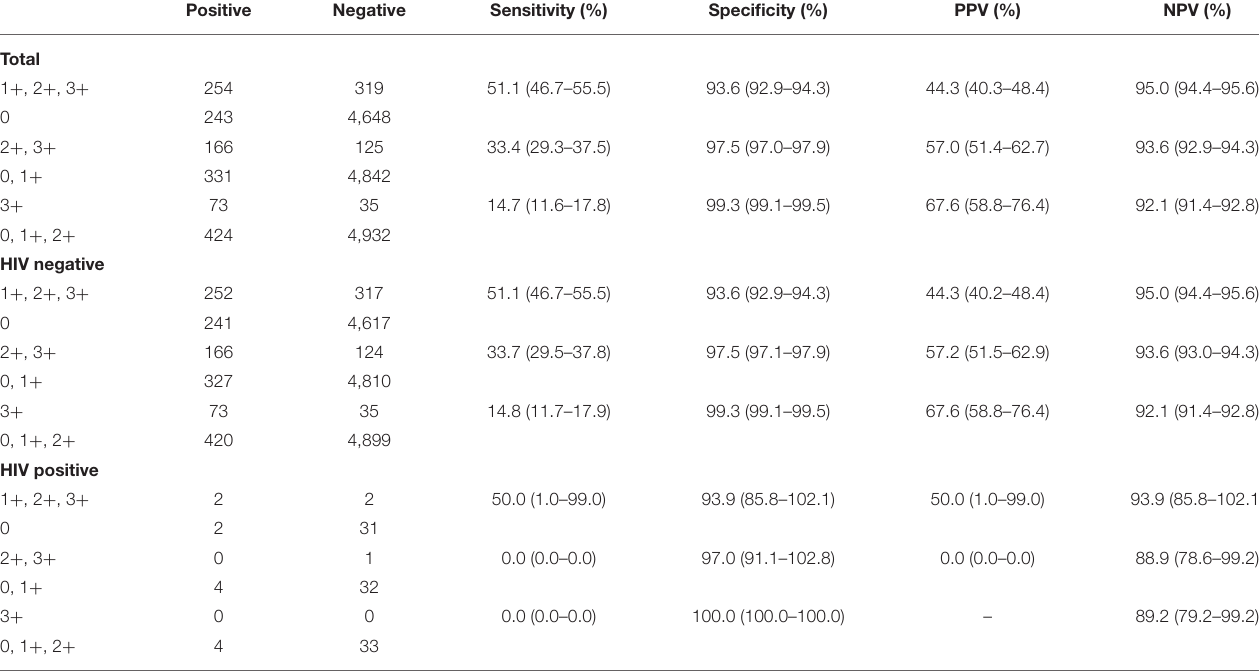
TABLE 5 | Diagnostic performance of LET to predict Chlamydia or Gonorrhoeae infection.